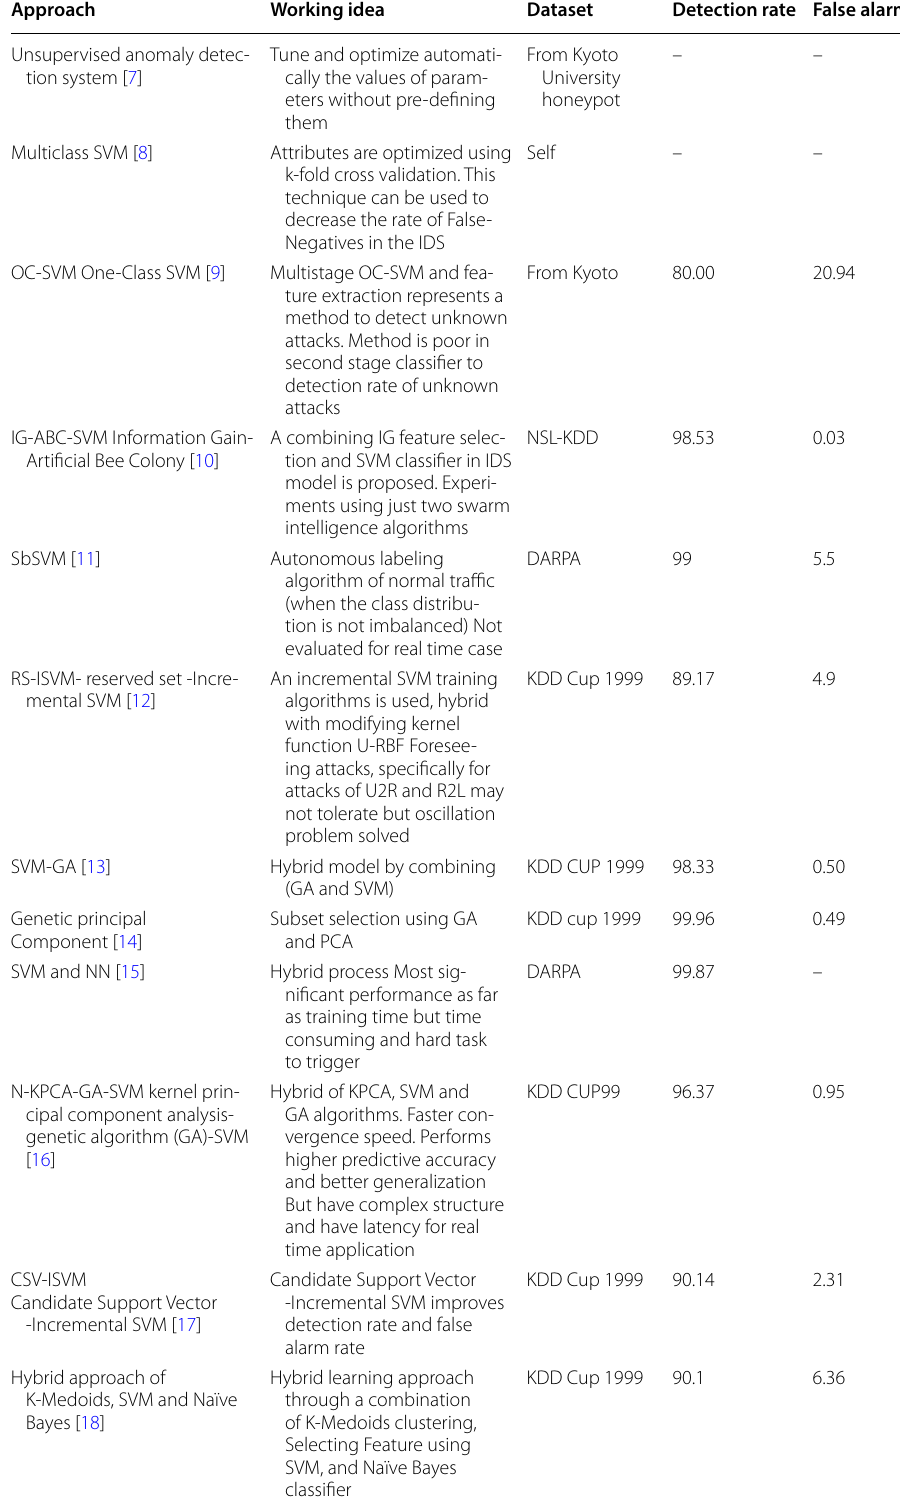
Table 1 Comparisons between Researches used SVM as basic Classifier Approach Working idea Dataset Detection rate False